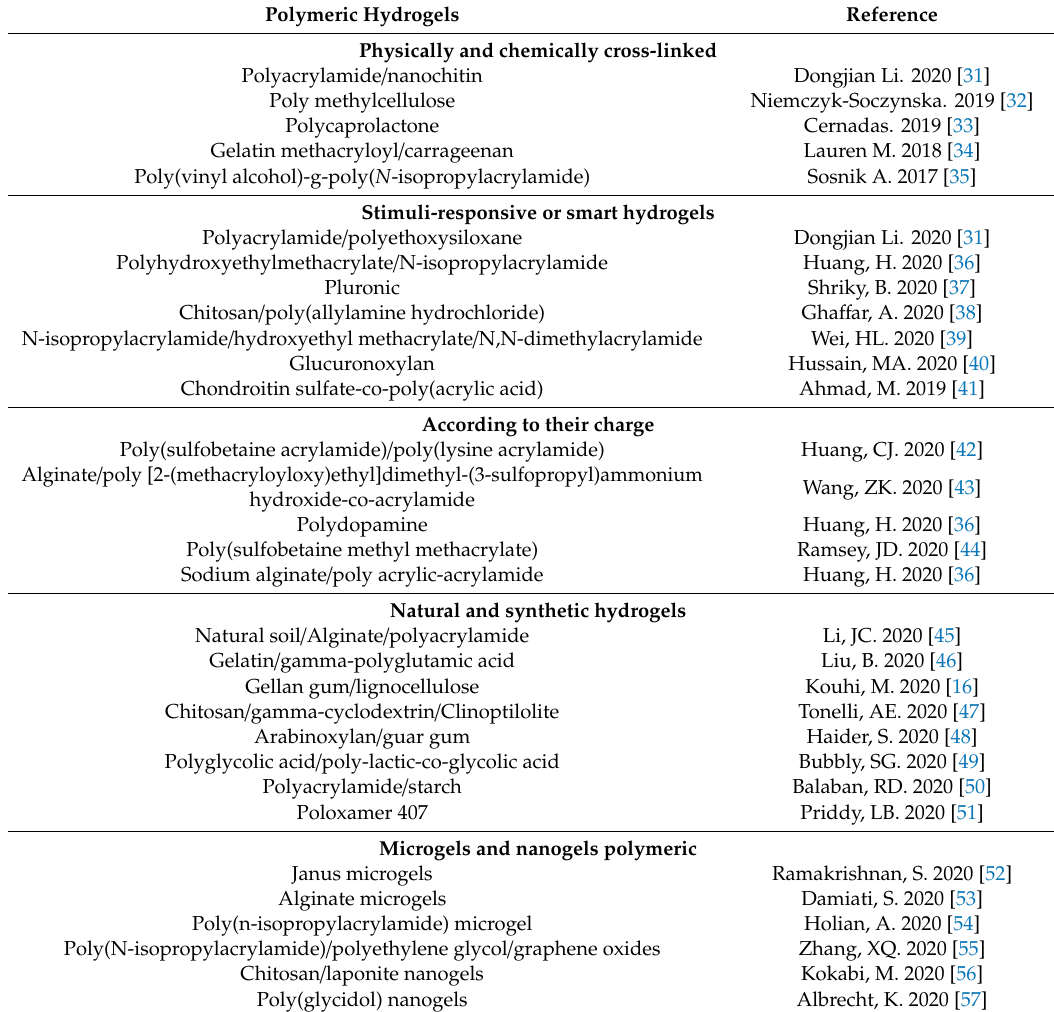
Table 1. Examples of polymeric hydrogels listed under respective classifications based on cross-linking, ionic charge, size, and